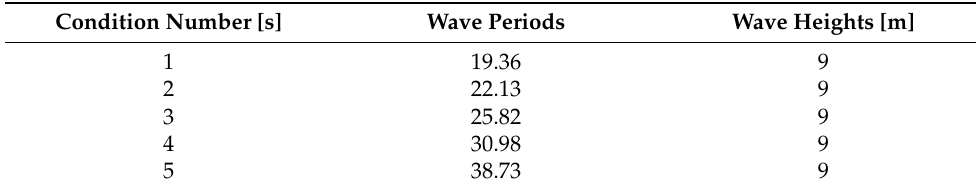
Table 8. The working condition of numerical simulation.